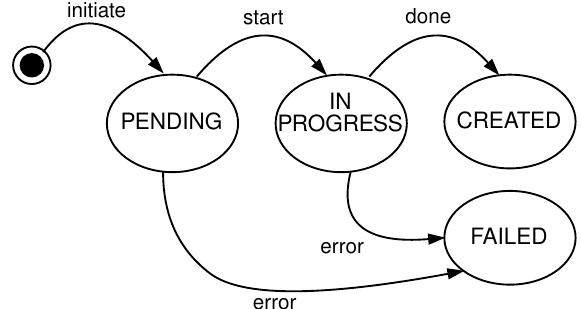
Figure 8. Newly submitted task state